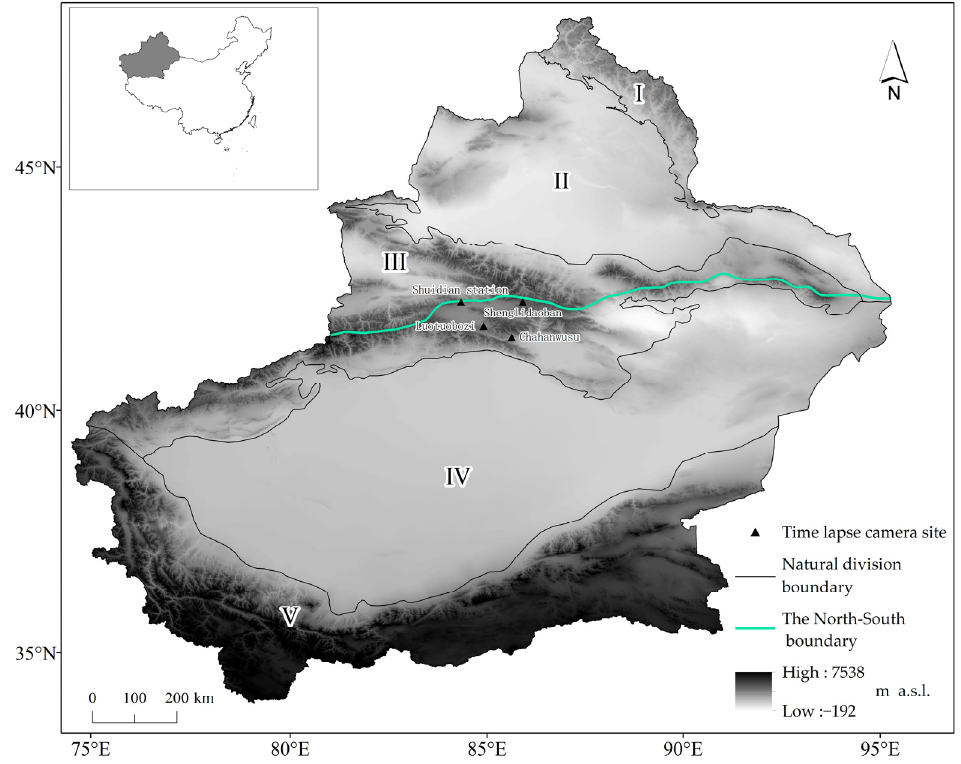
Figure 1. Study area and time − lapse camera stations: (I) Altai Mountains; (II) Junggar Basin; (III) Tienshan Mountains; (IV) Tarim Basin; (V). Kunlun Mountains.